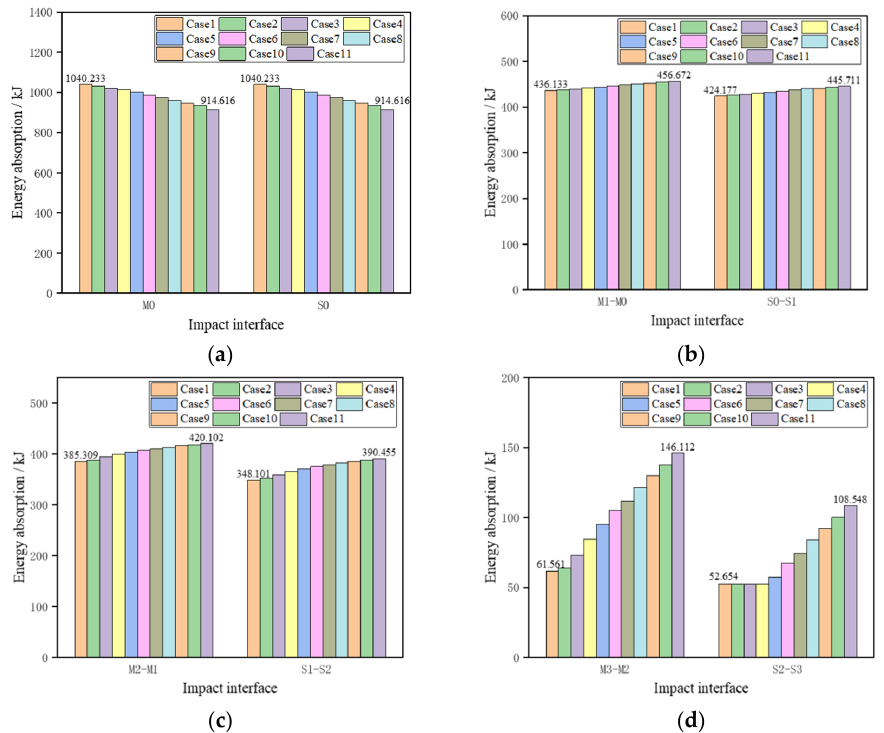
Figure 17. Influence of the slope of platform force change on specific impact interfaces: ( a ) the head cars: M0 and S0; ( b ) the first middle car interfaces; ( c ) the second middle car interfaces; ( d ) the third middle car interfaces.